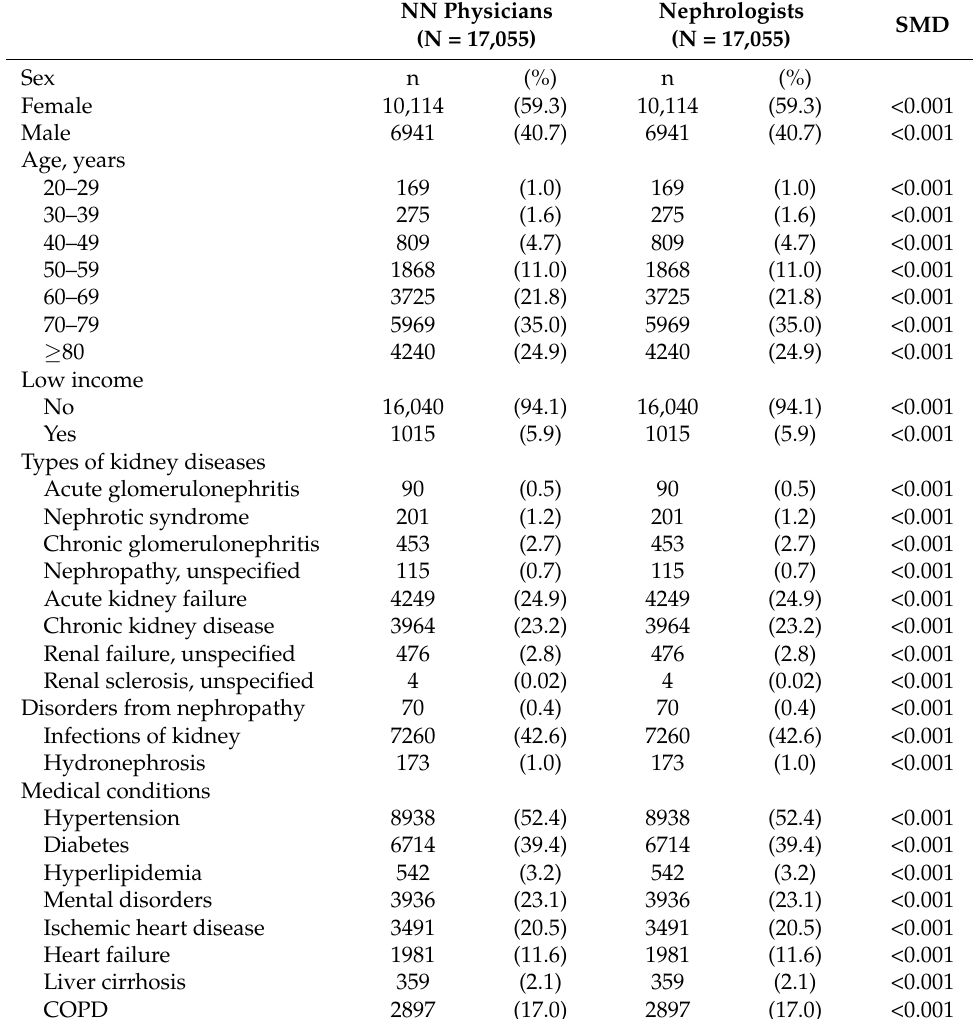
Table 1. Characteristics of patients hospitalized due to kidney diseases received care by nephrologists and non-nephrologist physicians (after matching)